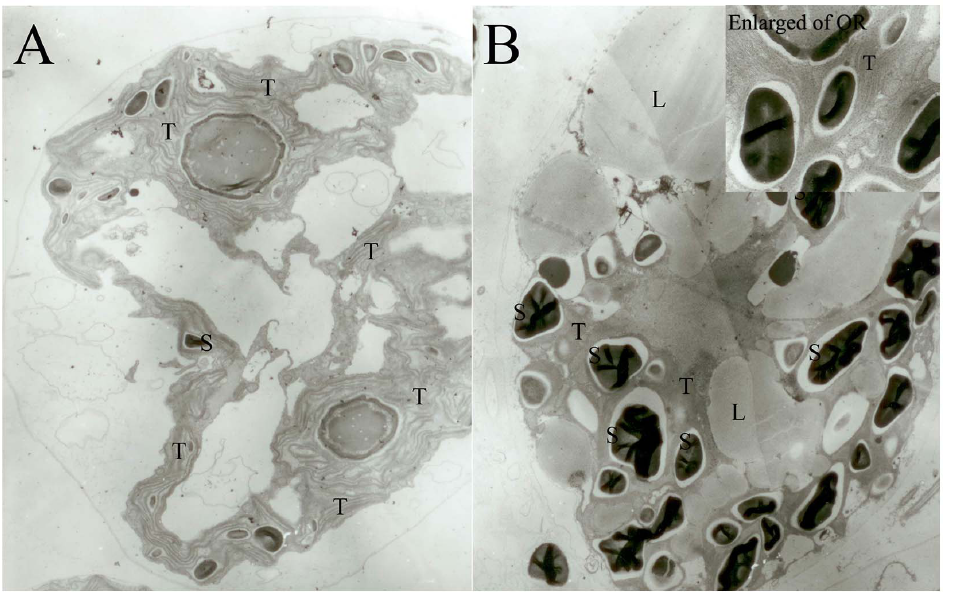
Figure 2. Thin-section electron observations of GV and OR cells. A, GV were rich in continuous thylakoid where photosynthesis took place. A small number of starch granules were observed and almost no lipid body was observed in GV. B, OR showed dramatic decrease in thylakoid volume and significant increase in starch granules and lipid bodies. Thylakoid around starch granules was continuous in OR (the enlarged of OR). S in figure represents starch; T represents thylakoid; L represents lipid bodies.